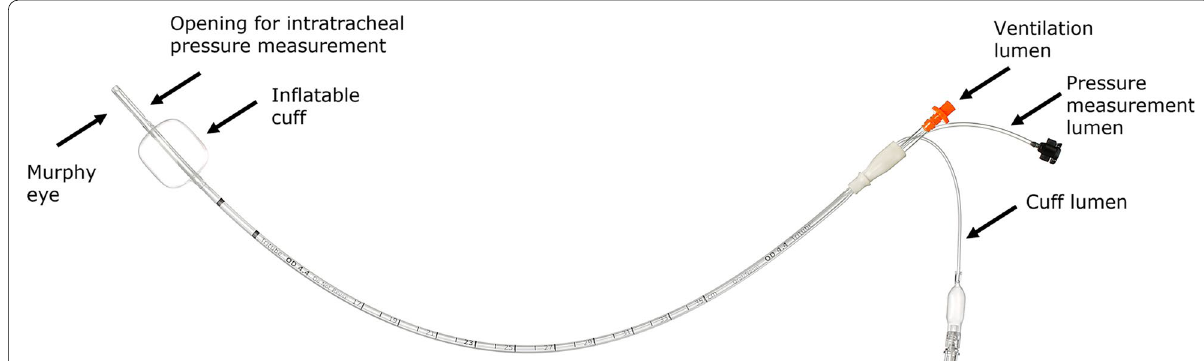
Fig. 1 Tritube. Cuffed endotracheal tube with 45-cm length and 4.4-mm outer diameter for adult patient ventilation in combination with